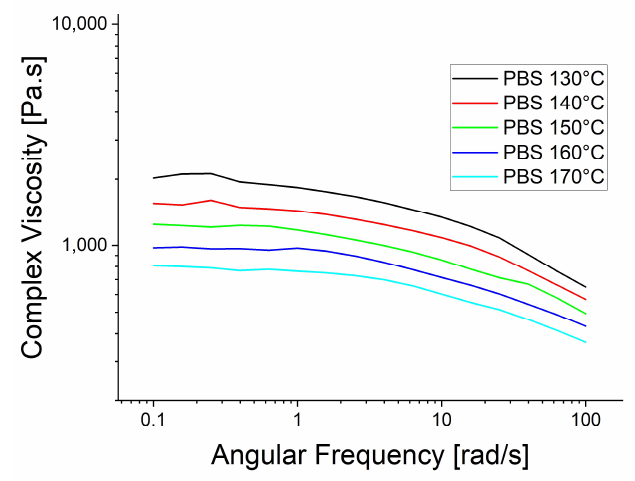
Figure 8. Rheological temperature sweep for PBS.